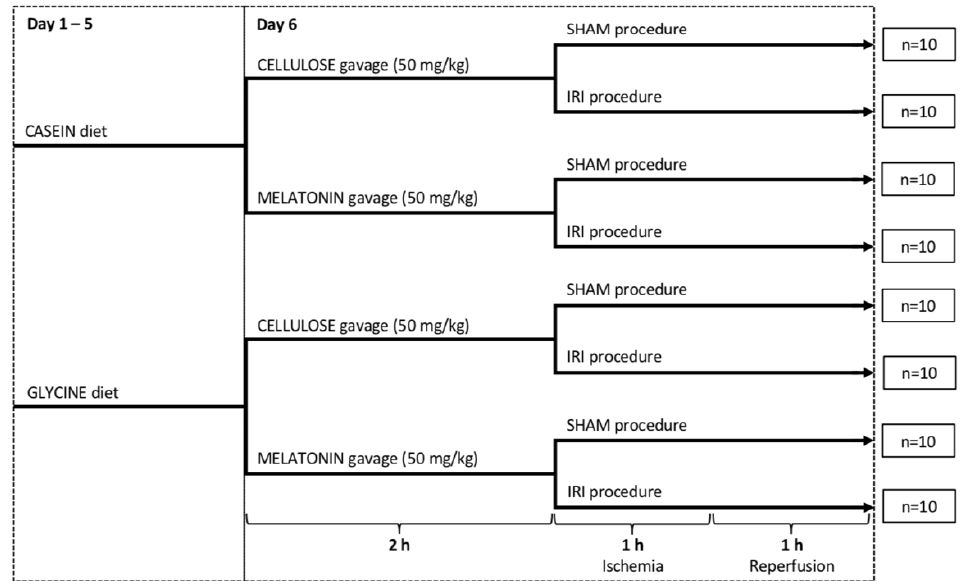
Figure 5. Study design. IRI: ischemia/reperfusion injury.